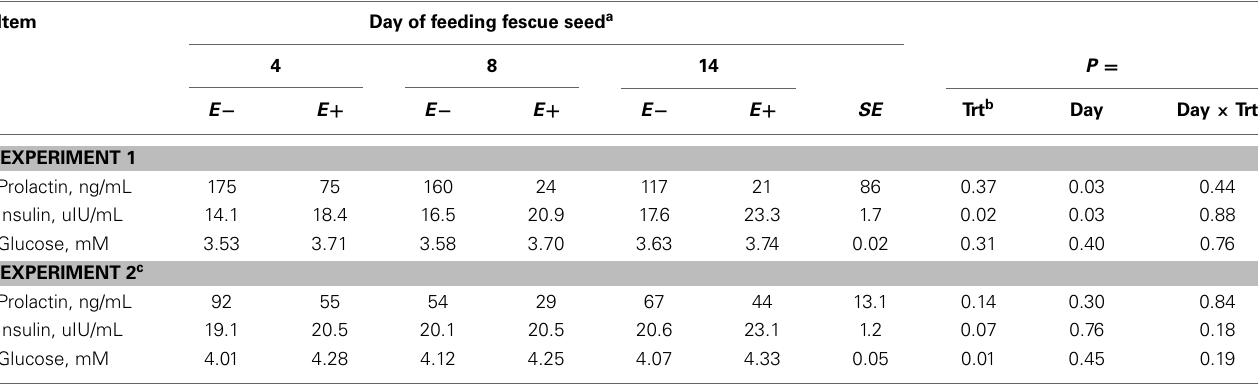
Table 5 | Serum insulin, serum prolactin, and plasma glucose concentrations for steers fed endophyte-free (E − ) or endophyte-infected (E + ) fescue seed above (Experiment 1) or within (Experiment 2) their thermoneutral